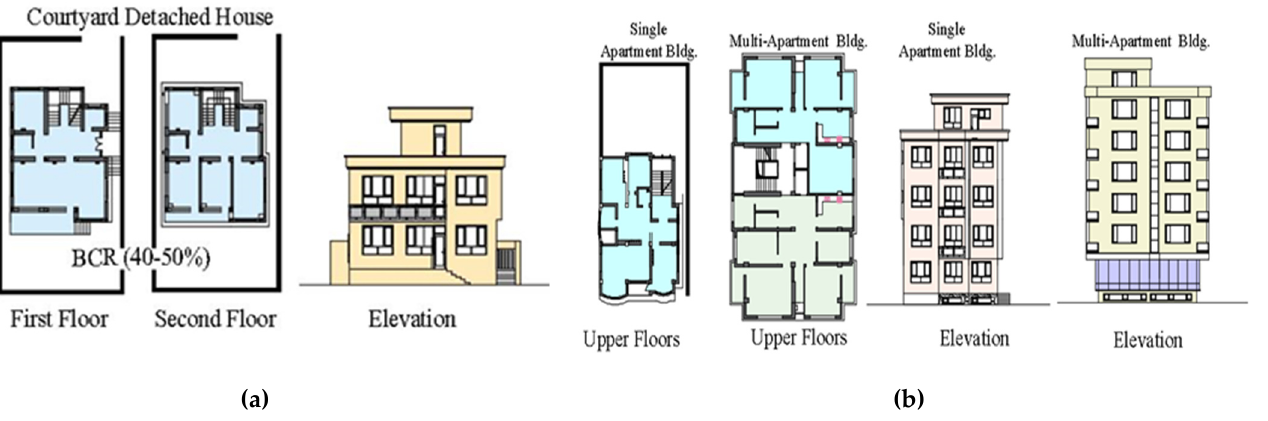
Figure 3. Existing types of buildings layouts in Study Areas; ( a ) detached house scheme designed for low rise residential neighborhoods; ( b ) transformed scheme of houses with single type apart- ment buildings and multiple apartment buildings.